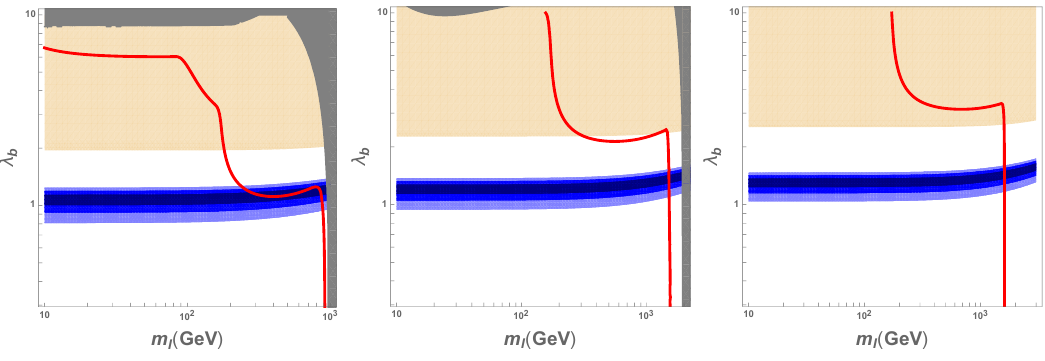
Figure 14 . The predictions of the DM relic density, C (cid:22); NP